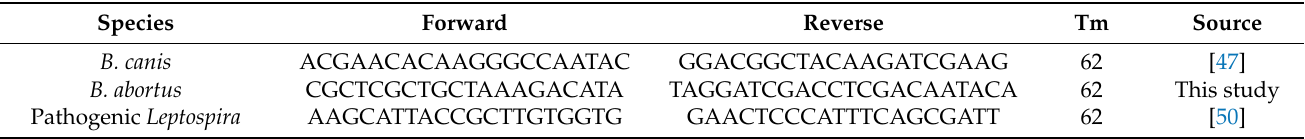
Table 2. Primer sequences, Tm and source for qPCR analysis of B. abortus , B. canis , and pathogenic Leptospira .